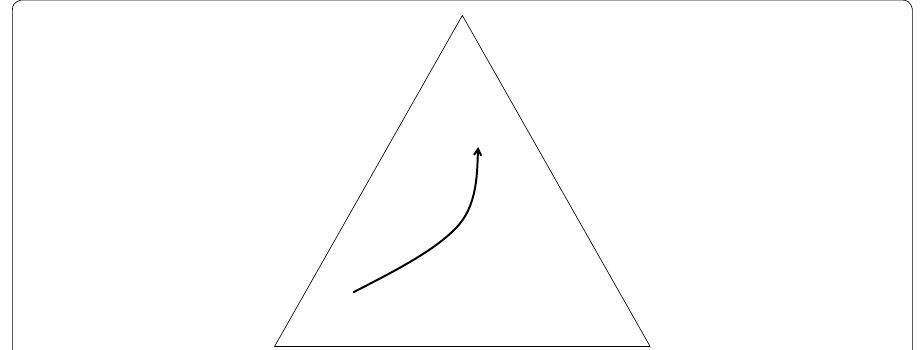
Fig. 3 Example of a (continuous) trajectory on the